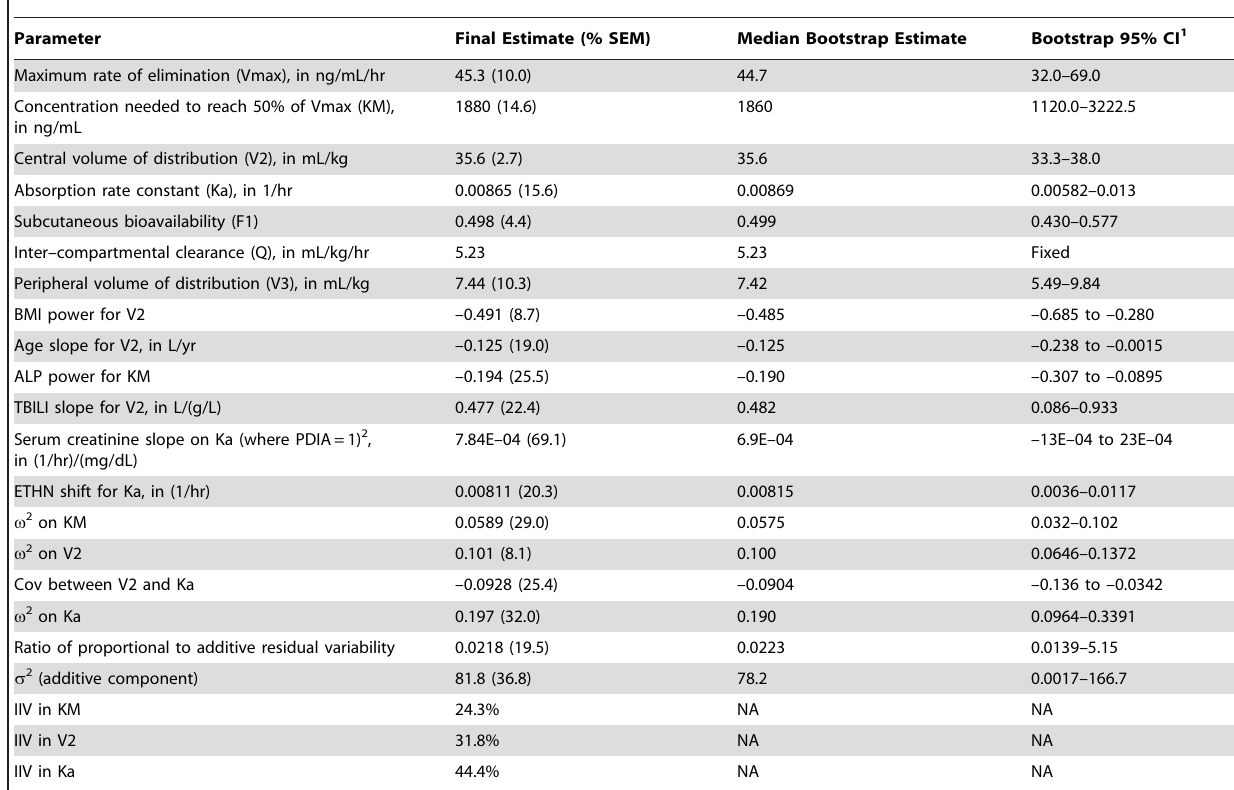
Table 6. Peginesatide parameter estimates and their associated precision for the final PK model, including bootstrap evaluation